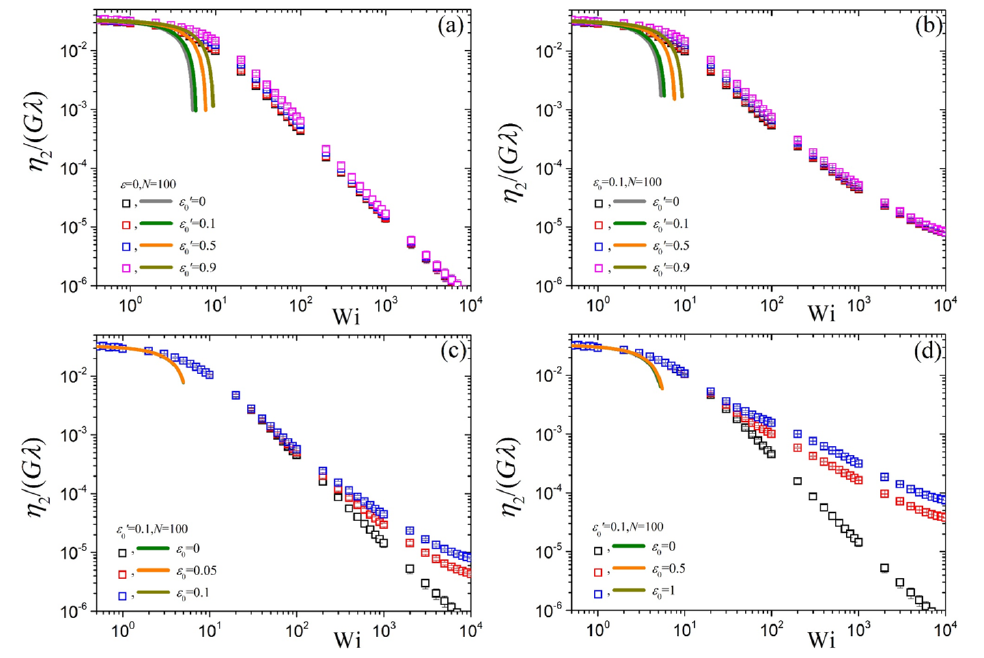
Figure 6. Predictions for η 2 ( ˙ (cid:101) ) / G λ , analogous to Figure 4, as a function of dimensionless elongation rate Wi for N = 100 and various values of the parameters ε 0 and ε (cid:48) . ( a ) ε 0 = 0, various ε (cid:48) , ( b ) ε 0 = 0.1, 0 0 = 0.1, various ε various ε (cid:48) , ( c , d ) ε (cid:48) 0 . The solid lines mark the predictions of the small rate expansion, 0 0 = 0. Equation (24), or Equation (25) for the case of ε (cid:48) 0